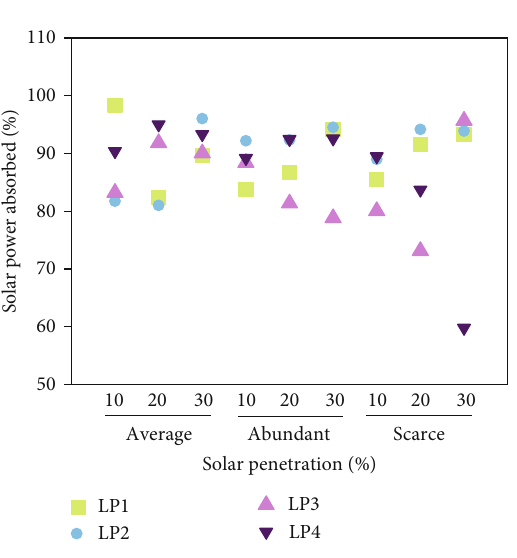
Figure 4: Solar power absorption levels for the 24 h DEDs of the load pro fi les (LPs) under average, abundant, and scarce solar resource conditions. Table 5: Load factors of various load pro fi les